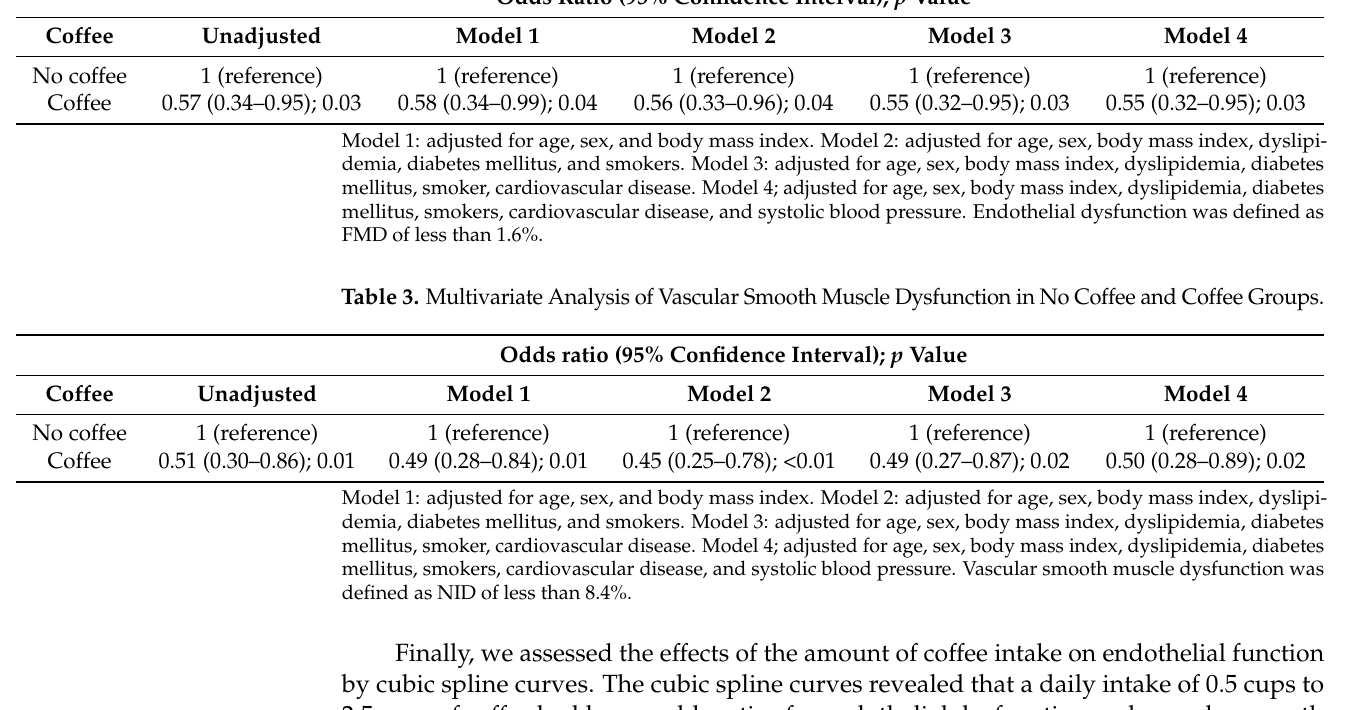
Figure 1. Bar graphs show flow-mediated vasodilation ( A ) and nitroglycerine-induced vasodilation ( B ) in patients with hypertension who did not drink coffee and patients with hypertension who drank coffee. Table 2. Multivariate Analysis of Endothelial Dysfunction in No Coffee and Coffee Groups. Odds Ratio (95% Confidence Interval); p Value